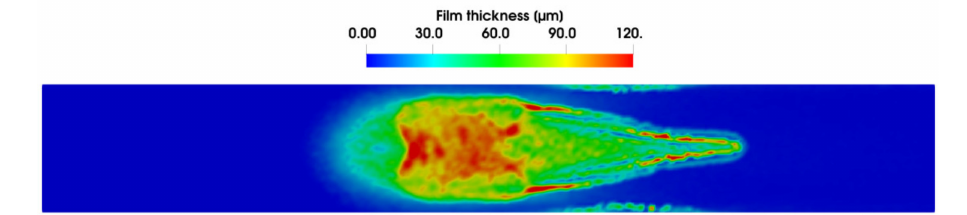
Figure 12. Formation and evolution of AdBlue thin film in configuration